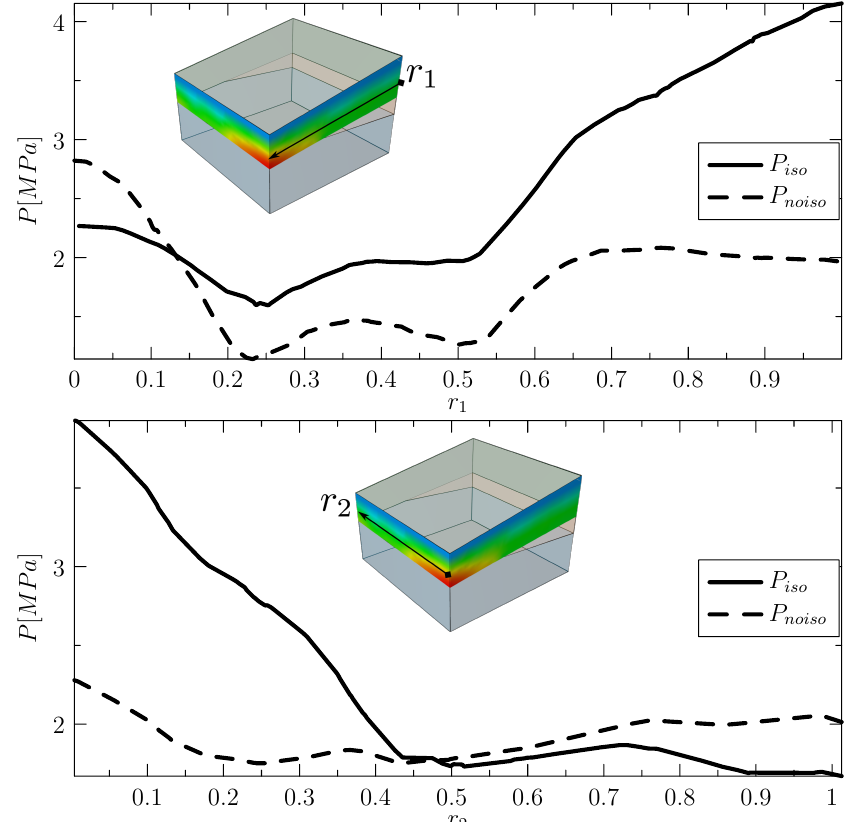
Figure 14. Pressure field on the lateral (on top) and front (on the bottom) lines r 1 and r 2 , respectively. Solid ( P iso ) and dashed line ( P no iso ) mark the results obtained considering and neglecting the effect of − erosion and of the isostasy movements,